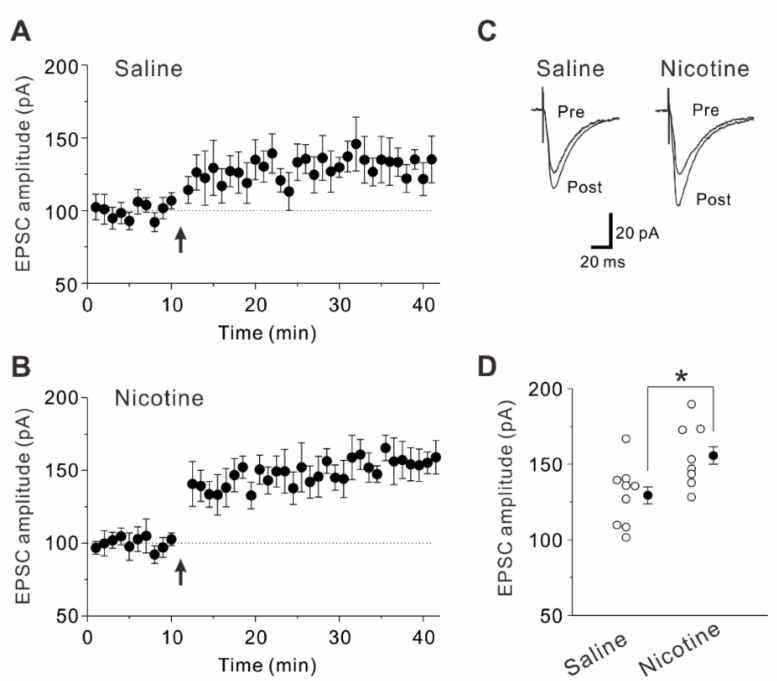
Figure 2. Enhanced synaptic potentiation caused by adolescent nicotine exposure. ( A ) Synaptic potentiation was induced in PNs of saline-treated mice (n = 9 neurons/6 mice) by LTP-inducing protocol (arrow: 80 presynaptic stimulations at 2 Hz with postsynaptic depolarization by clamping at +30 mV). ( B ) Synaptic potentiation was induced in PNs of nicotine-treated mice (n = 8 neurons/7 mice) by LTP-inducing protocol (arrow). ( C ) Sample traces of evoked EPSCs obtained by averages of ten current traces under control condition (pre) and 25–30 min after LTP-inducing protocol (post). ( D ) Summary data of normalized EPSC amplitude obtained in ( A , B ). Unpaired t -test, *: p =